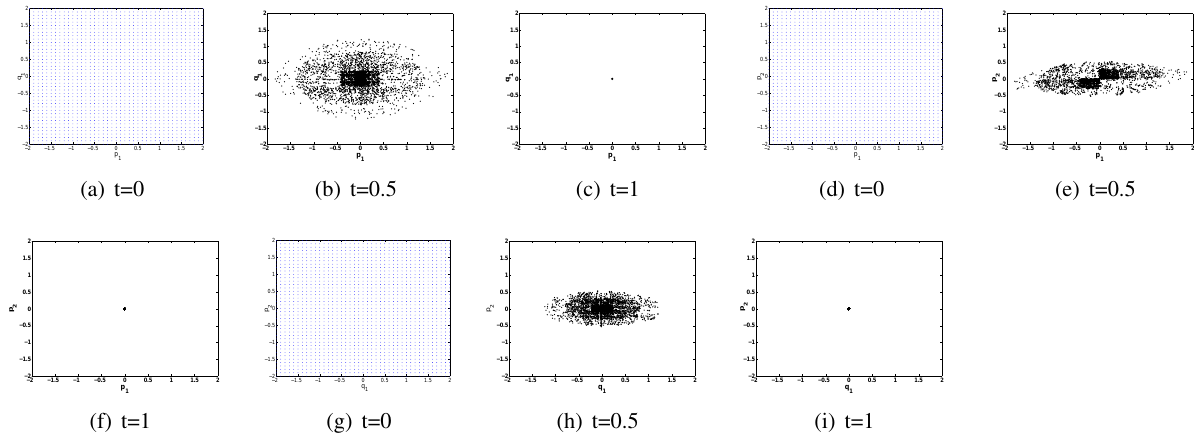
Fig. 1 Supports of invariant measure and random attractors for ϕ NGM 3 with case I